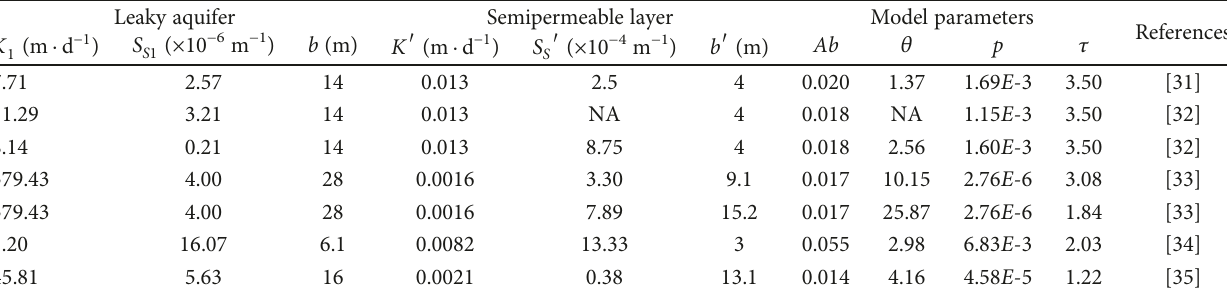
Table 1: Ranges of parameters ab , θ , p , and τ in the leaky con fi ned aquifer systems reported in the literature. Leaky aquifer